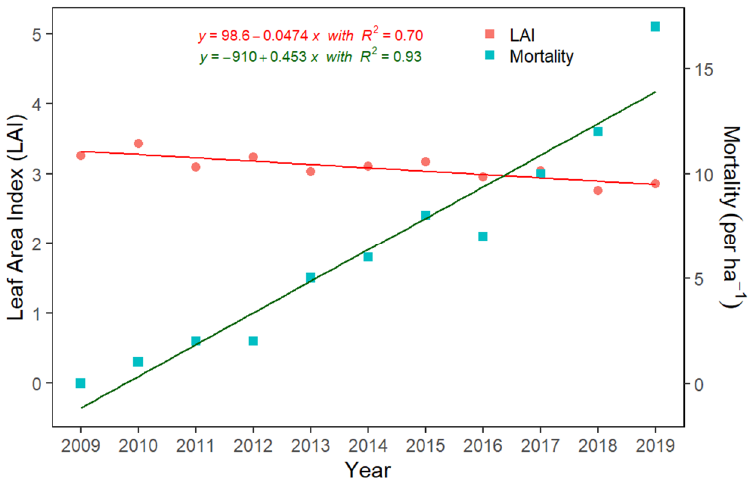
Figure 7. The linear relationship between leaf area index (LAI) and mortality with annual time series, using the annual averages from 2009–2019.